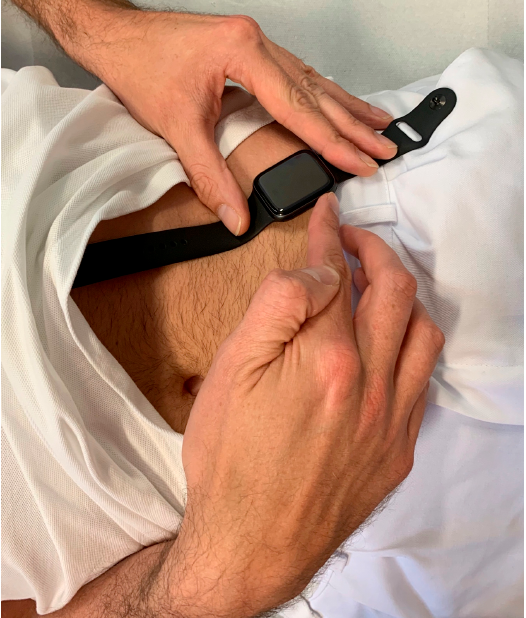
Figure 2. Registration of Einthoven lead II between the left lower abdominal region and the right index finger.